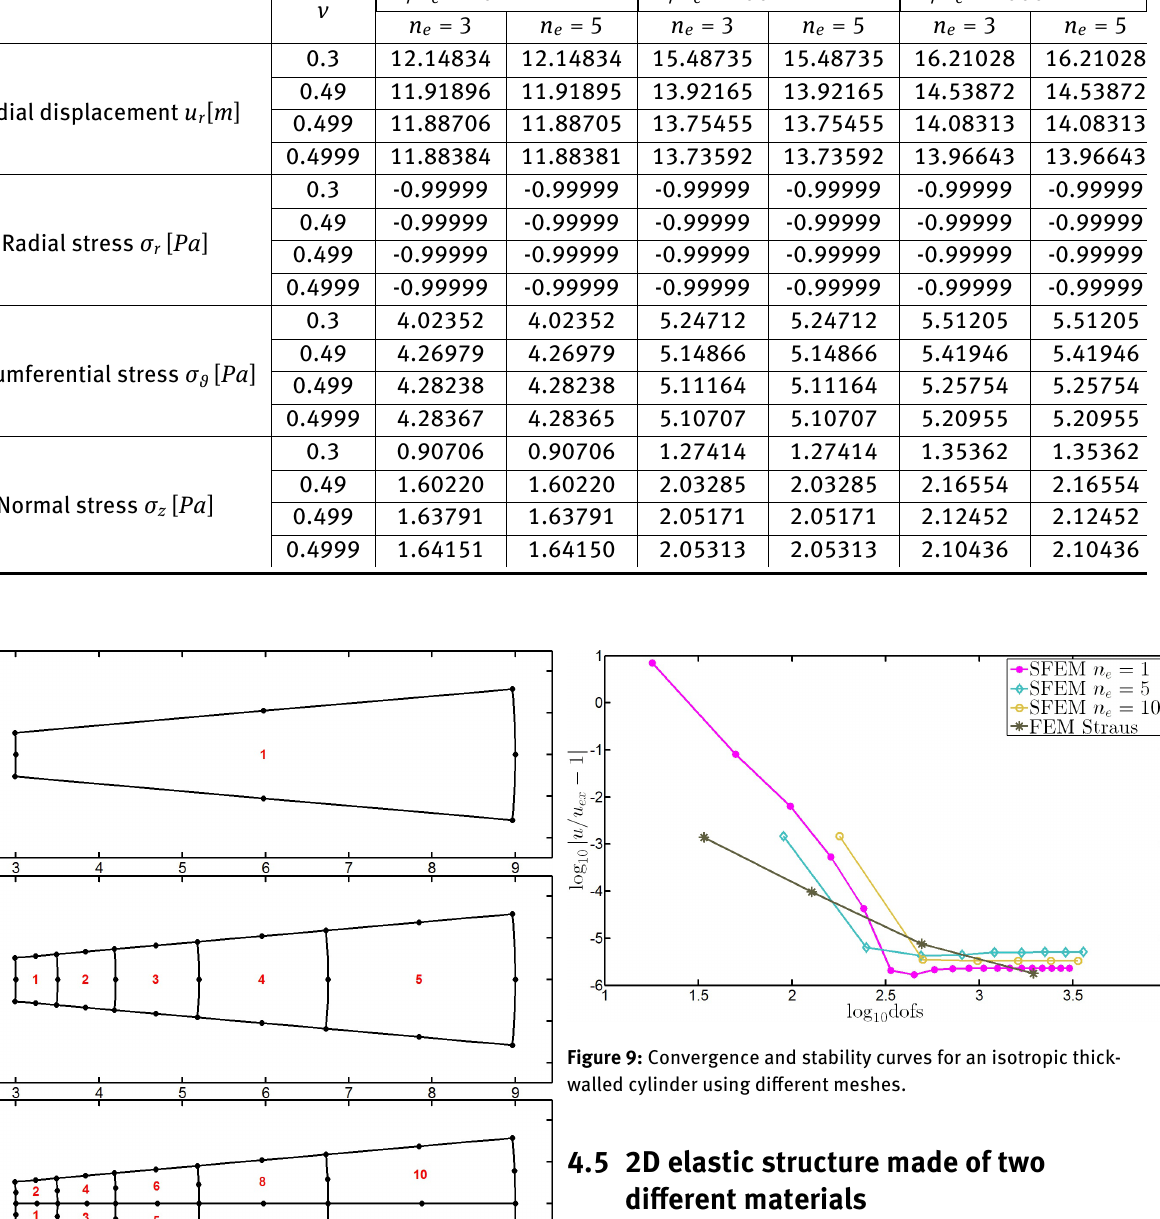
Table 5: Results for a thick-walled composite cyilinder for several values of the Poisson’s ratio and the ratio between the core and sheet moduli using 21 × 21 grid points per element and the meshes of Figure 10.